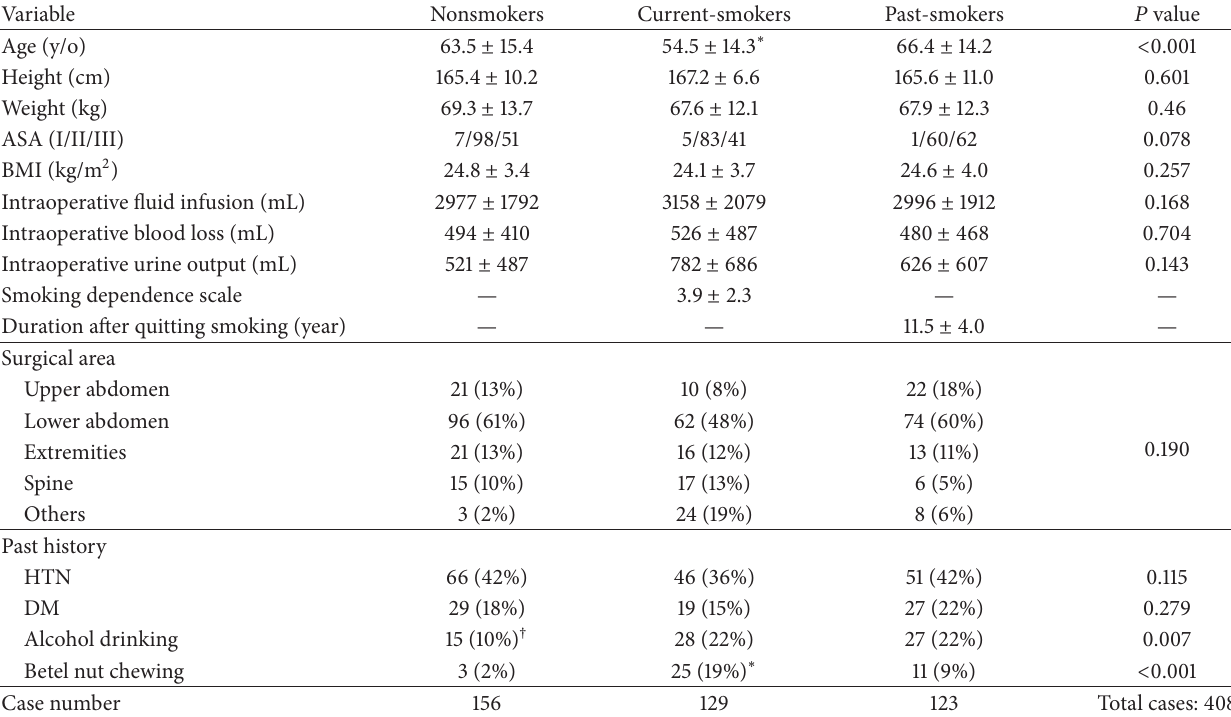
Table 1: Demographic data on male patients.